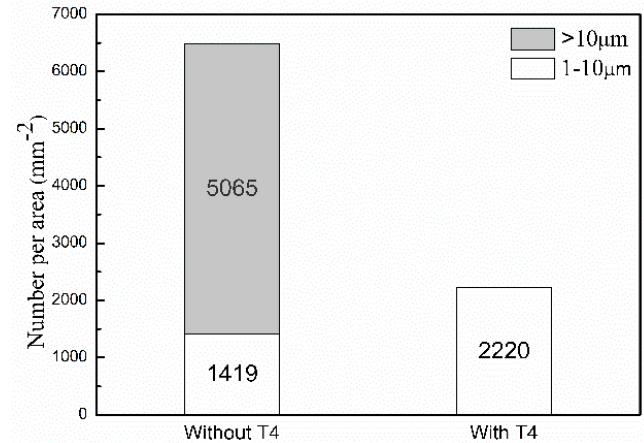
Figure 3. Particle-size distribution and number per area for the extruded TZA822 alloys.